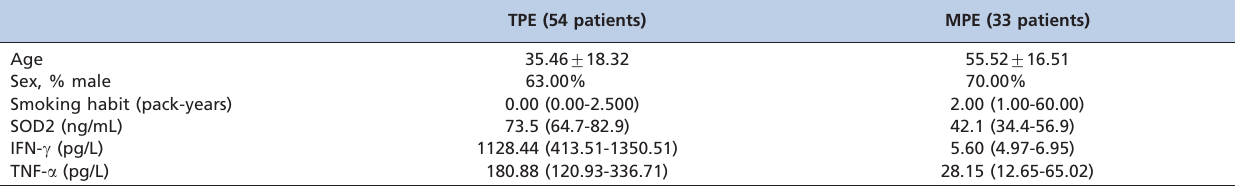
Table 1 - Characteristics of the